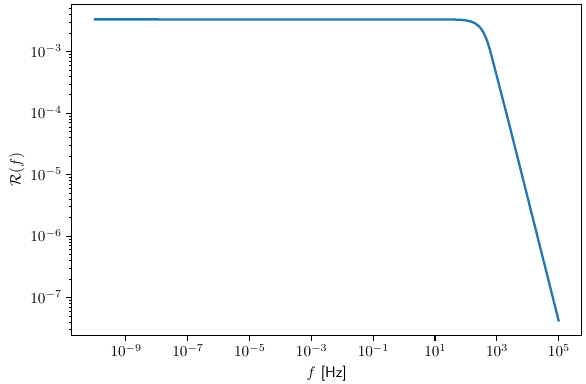
(cid:4) (cid:5) = K x , K y , K z ∼ 10 − 3 s o